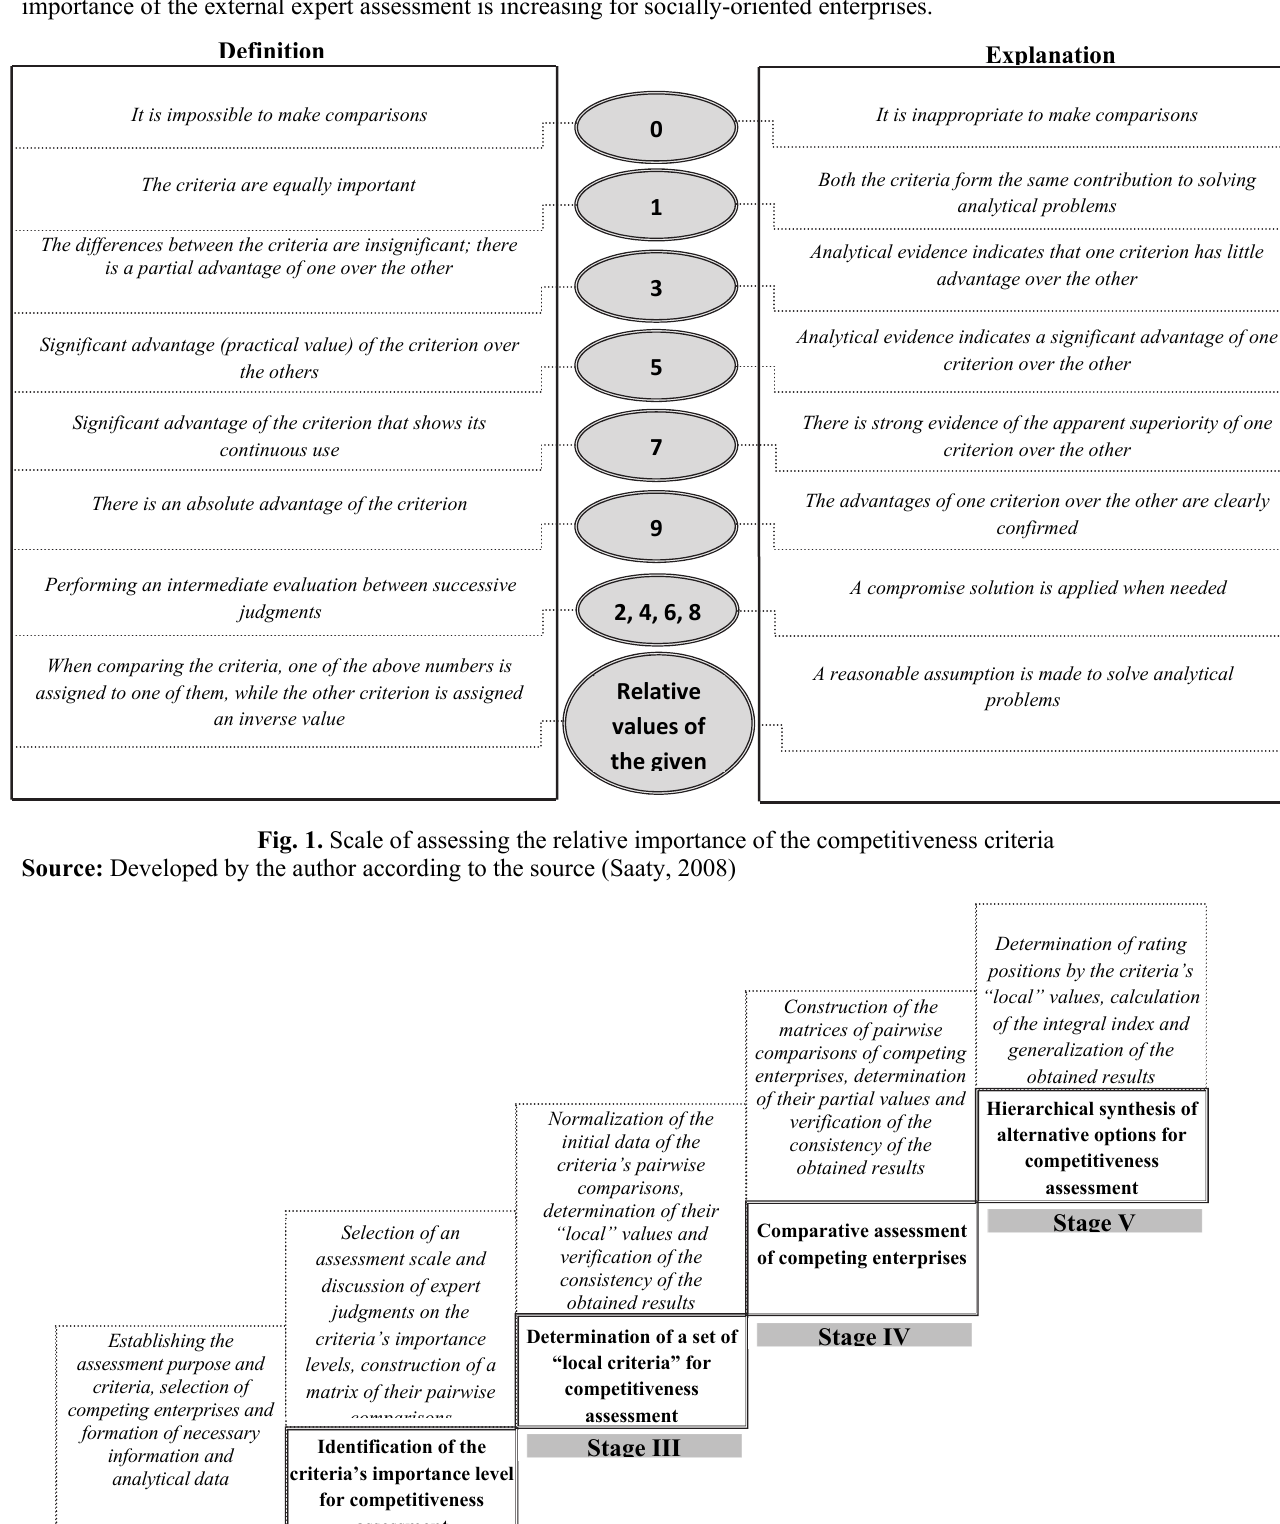
Fig. 2. Structural and logical scheme of the integral evaluation of the retailers’